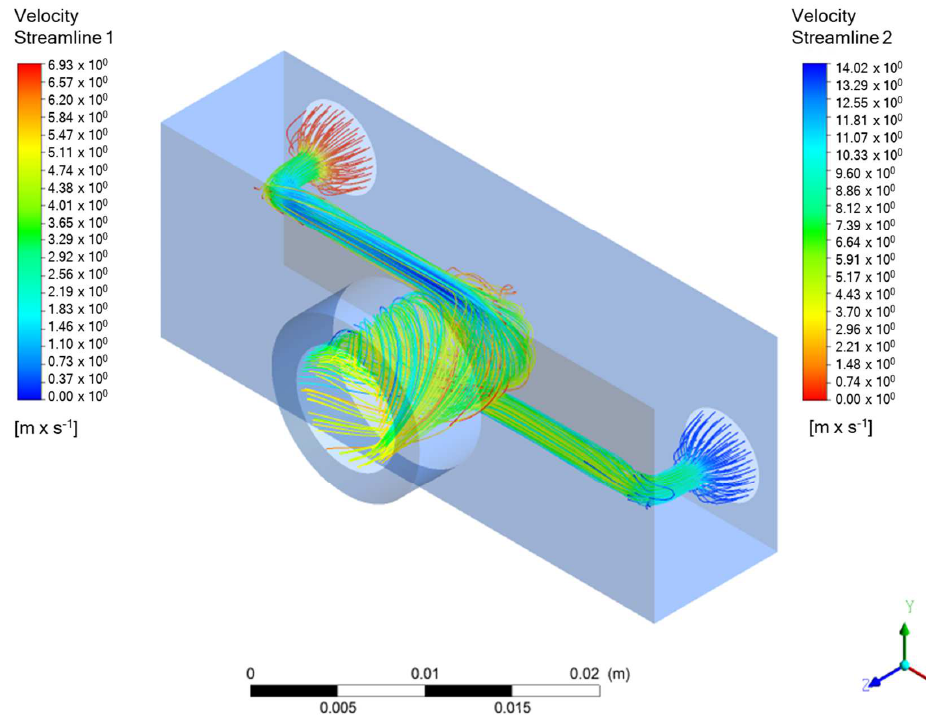
Figure 7. Vertical vortex combustor velocity streamline.